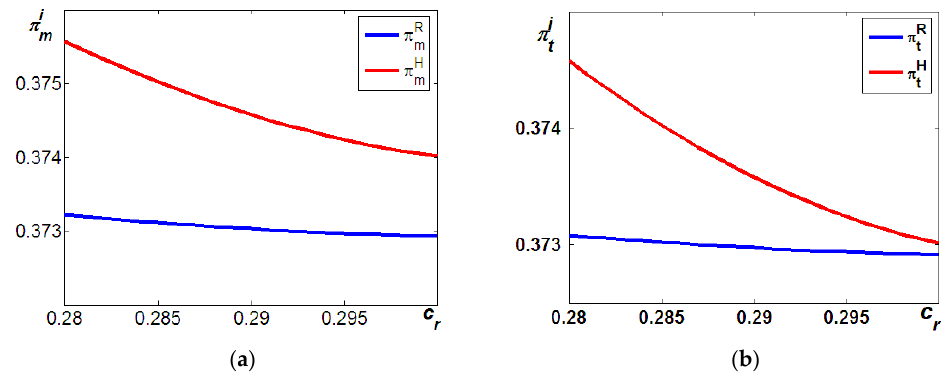
π π π π vs. H m vs. H t ; ( b ) R t . Figure 3. The difference in economic performance ( a ) π R m vs. π H m ; ( b ) π R t vs. π H t